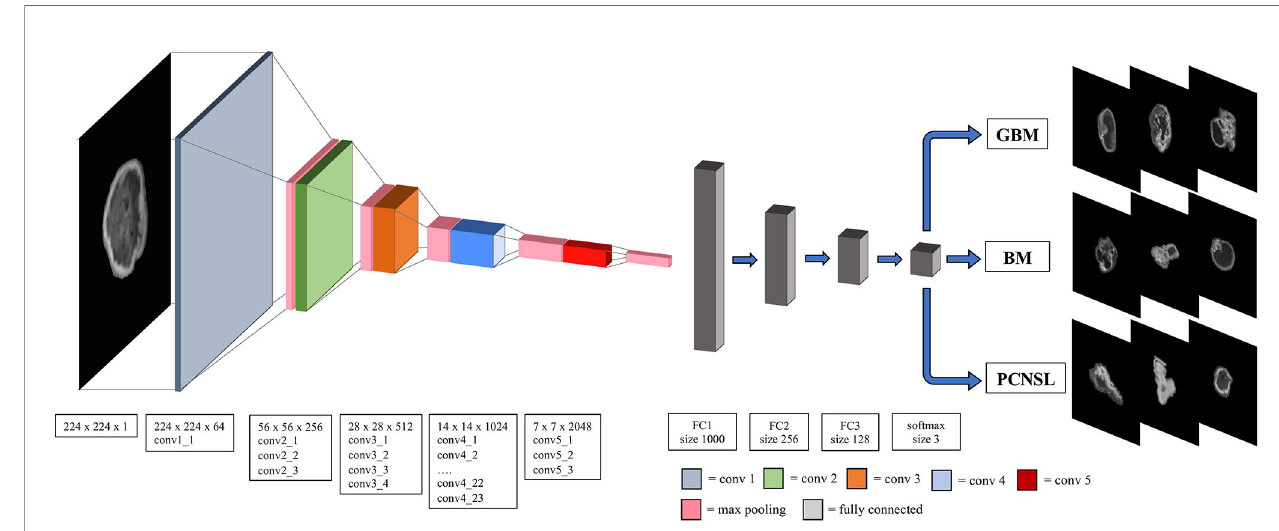
FIGURE 1 | The overall Resnet-101 model architecture. The window size and the stride for convolutional, maxpooling and fully connected layers are also presented. Conv, convolutional layer; FC, fully connected layer; GBM, glioblastoma multiforme; PCNSL, primary central nervous system lymphoma; BM, brain